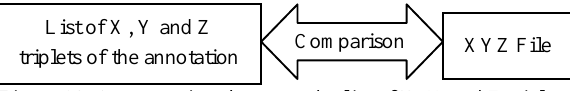
Figure 10: A comparison between the list of X, Y and Z triplets of the annotation and the XYZ files helps to project the annotation on the other images image.